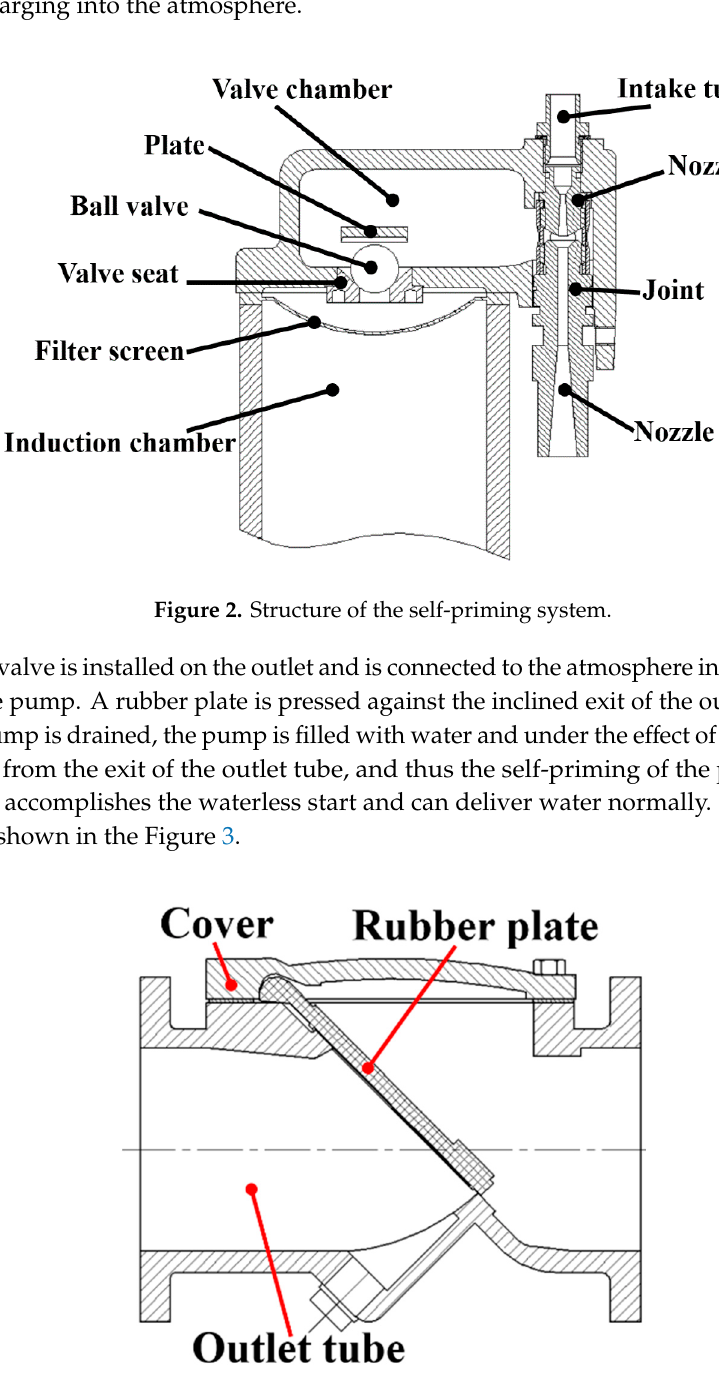
Figure 3. Structure of the outlet valve.